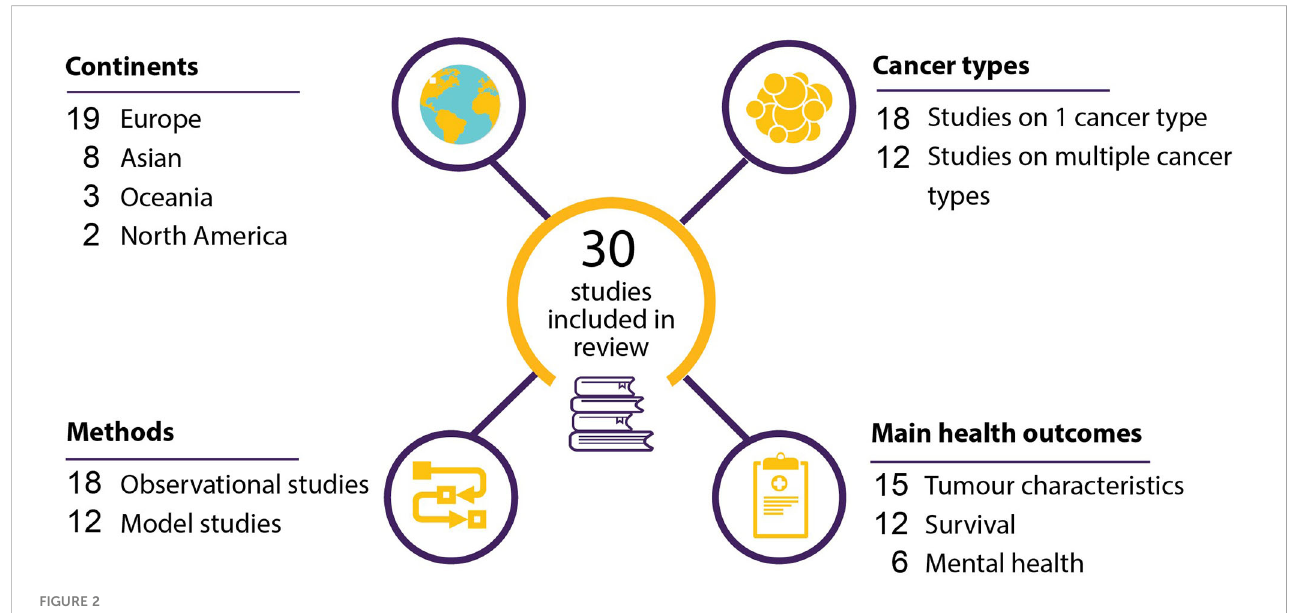
FIGURE 2 Overview of the characteristics of the included